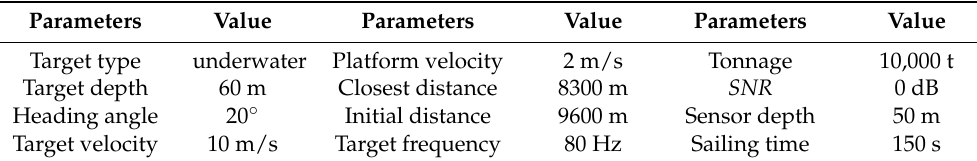
Table 5. Target simulation parameters of the underwater target.